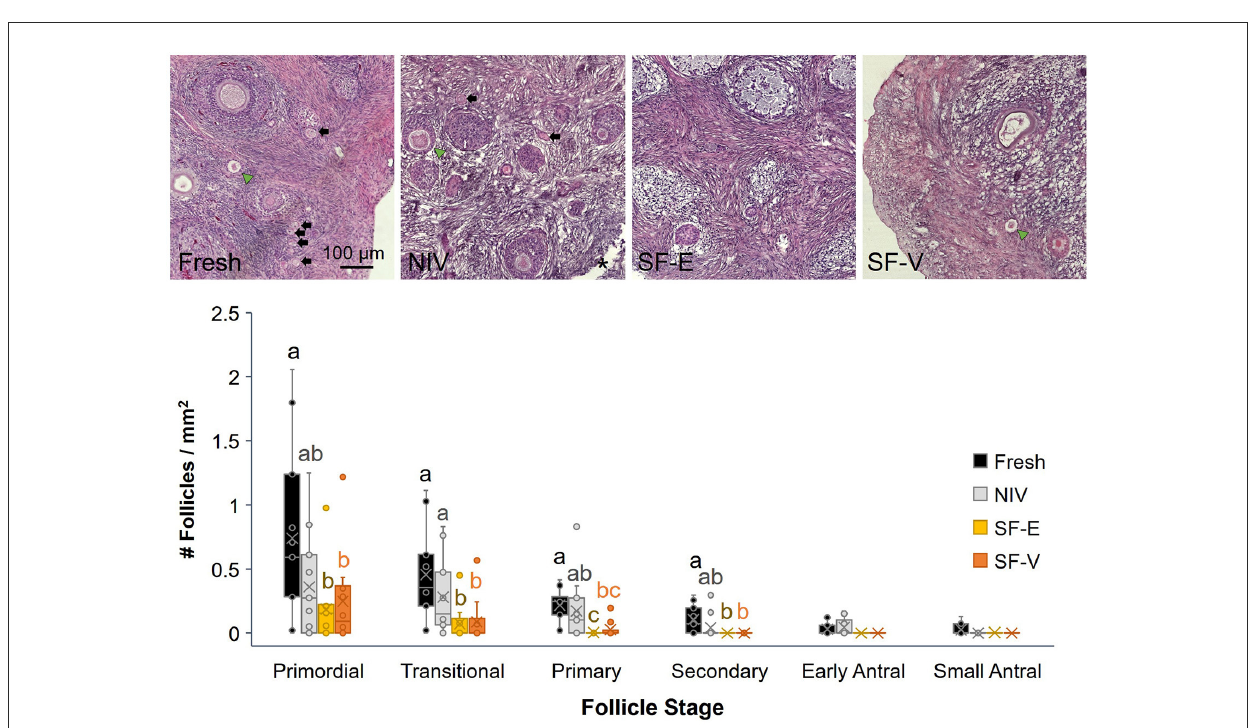
FIGURE4 Density (number/mm 2 tissue) of primordial, transitional, primary, secondary, early and small antral stage follicles in Fresh or cryopreserved-warmed [ via needle immersed vitrification (NIV), or slow-freezing with either 7.5% DMSO and EG (SF-E), or 15% DMSO and EG with 0.5M sucrose (SF-V)] African painted dog ovarian tissues ( n = 11), with representative images from a single individual (top) where morphologically normal follicles (black arrows), abnormal follicles (green arrow heads), and needle penetration site (asterisk *) are indicated. Box-and-whisker plots display median, quartile, and data range for follicle densities, with circles representing individuals. Letters indicate statistically significant differences in density among treatment groups per follicle stage following linear mixed model and post-hoc Tukey HSD test ( p < 0.05).